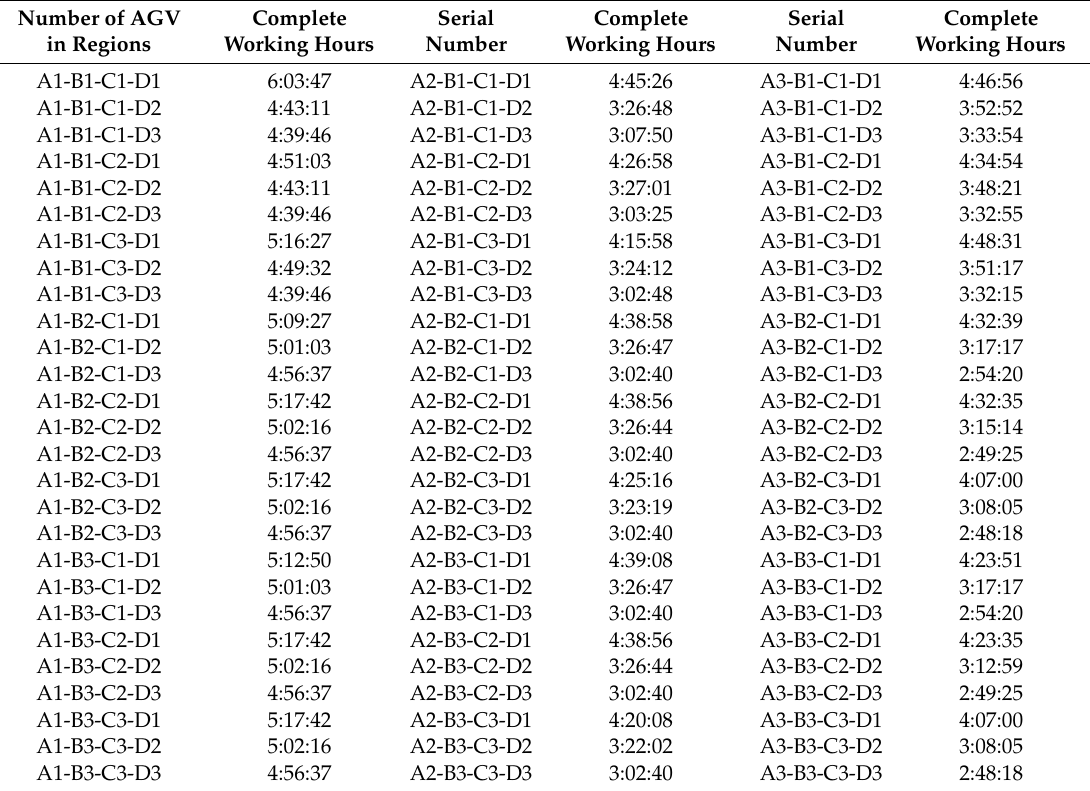
Table 11. Cross-regional independent resource pool simulation results.